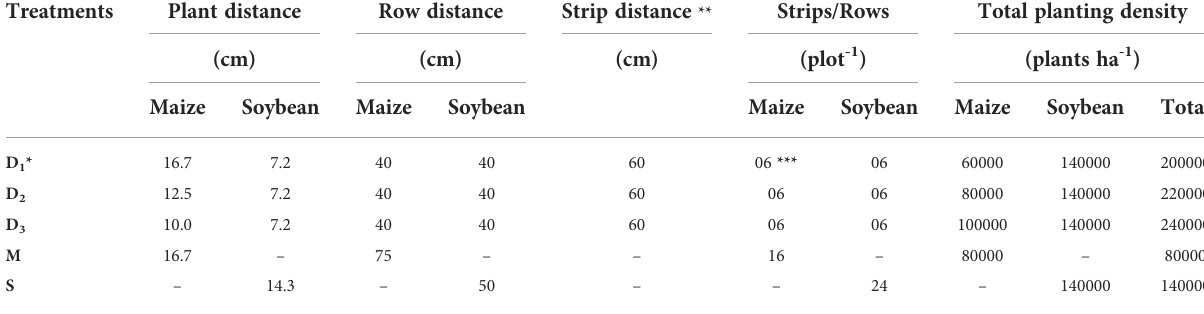
TABLE 1 The plant to plant, row to row, strip to strip distances for maize and soybean, and total planting densities of maize and soybean in intercropping and sole cropping systems. Treatments Plant distance Row distance Strip distance ** Strips/Rows Total planting density